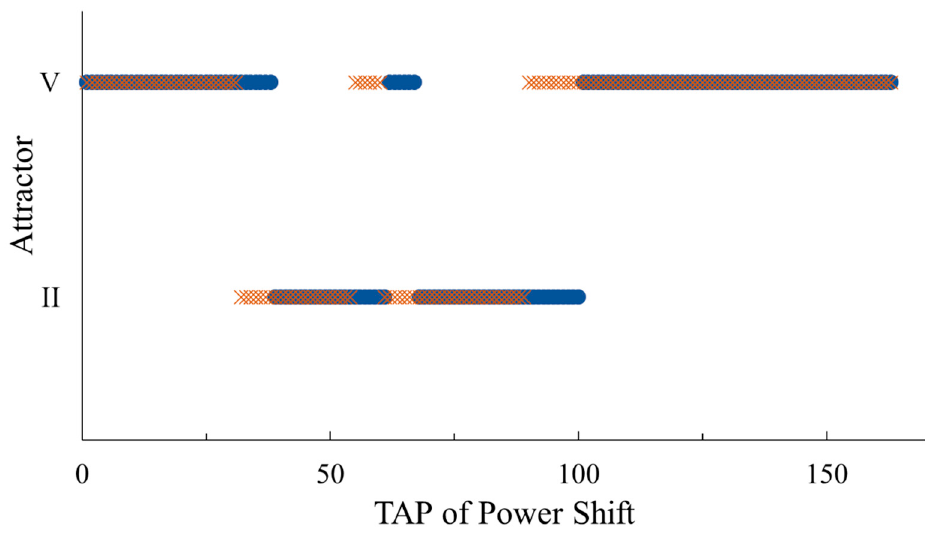
Figure 13. Comparison of the power shift without a lag in blue dots and with T lag = 15 τ at Y 0 = 1.63 for base AIII with Y PS = 1.84 in orange x s. The vertical axis represents the resultant attractor for a power shift.